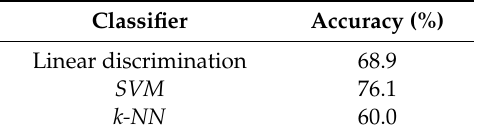
Table 3. Classification accuracy of healthy subjects, ET patients and CD patients.